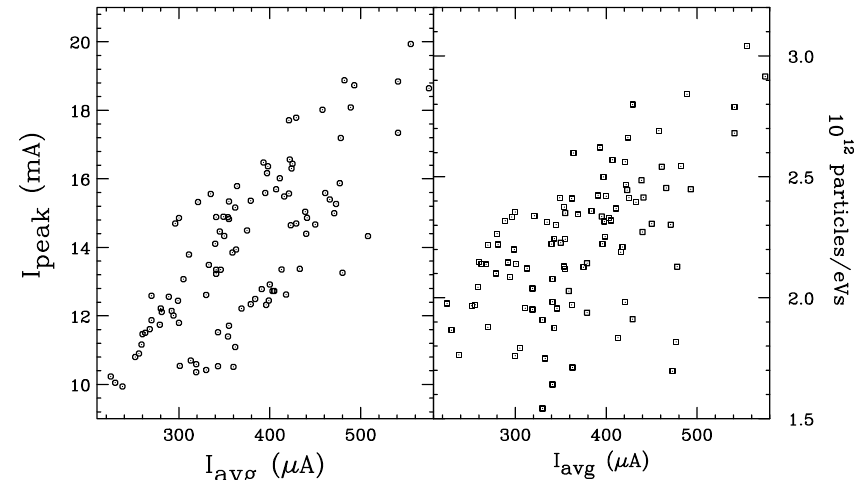
FIG. 3. Left: The peak beam intensity (in mA) versus the average beam intensity (in m A) for our phase-shift experimental data. Right: The beam brightness defined as the number of particles in a bunch divided by the rms phase space area. The unit is 10 12 particles (cid:1) eV s.